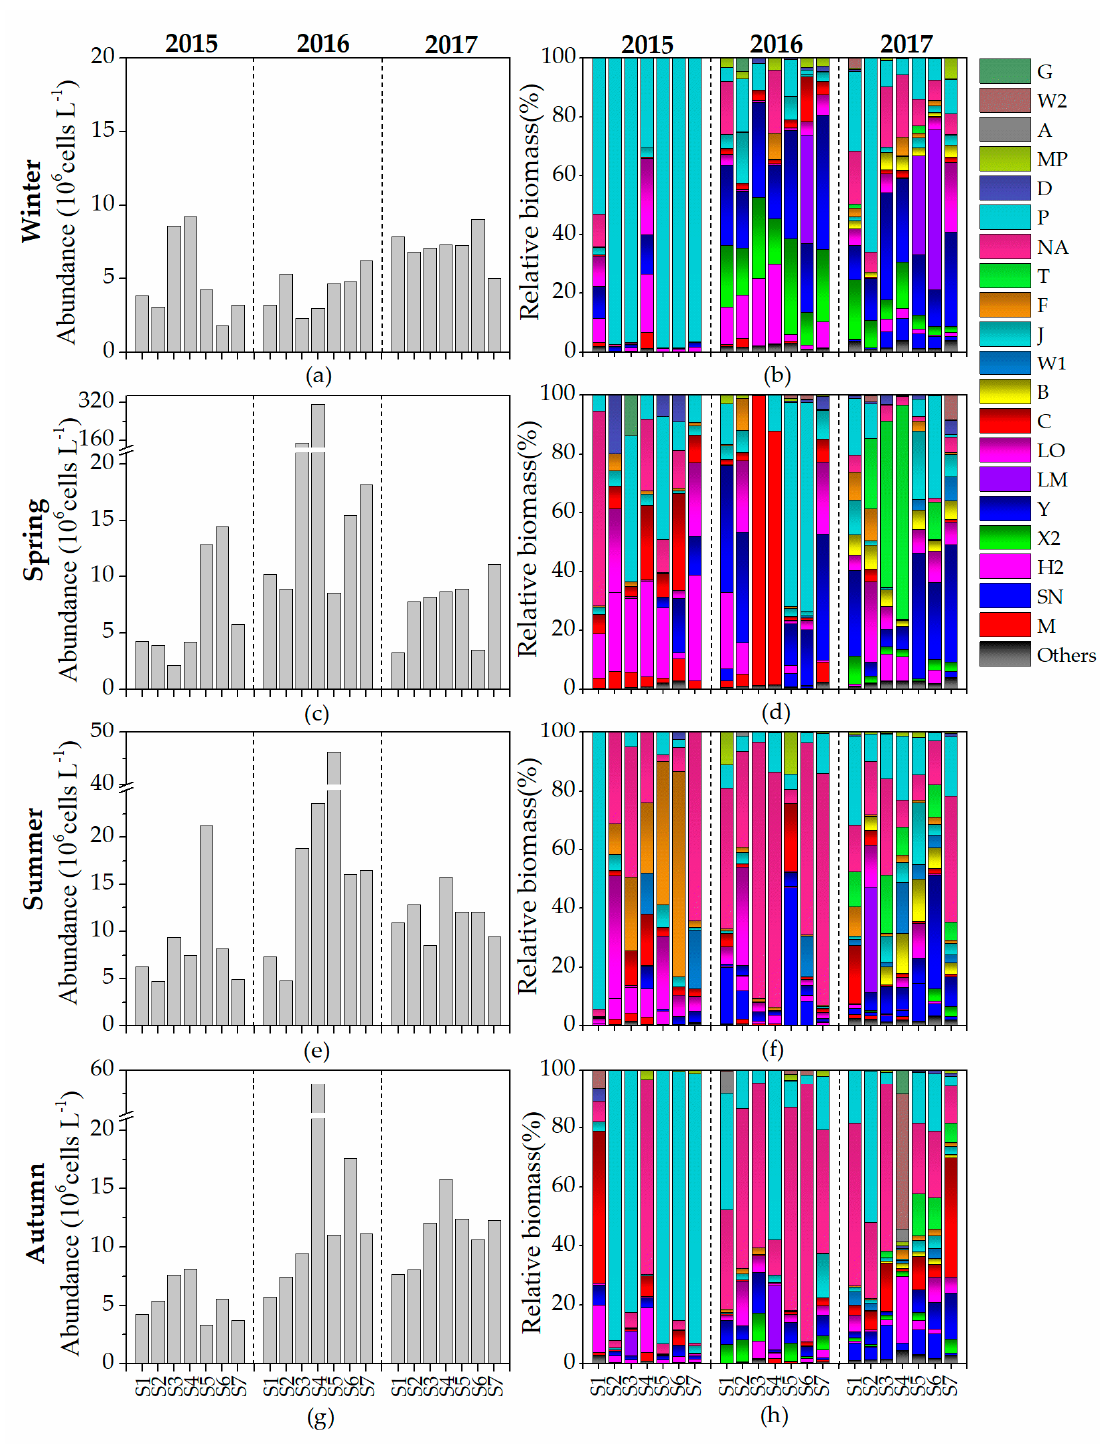
Figure 2. Composition and abundance of the representative functional groups of phytoplankton in Gaozhou Reservoir from 2015 to 2017. ( a ) abundance in winter; ( b ) relative biomass in winter; ( c ) abundance in spring; ( d ) relative biomass in spring; ( e ) abundance in summer; ( f ) relative biomass in summer; ( g ) abundance in autumn; and ( h ) relative biomass in autumn.